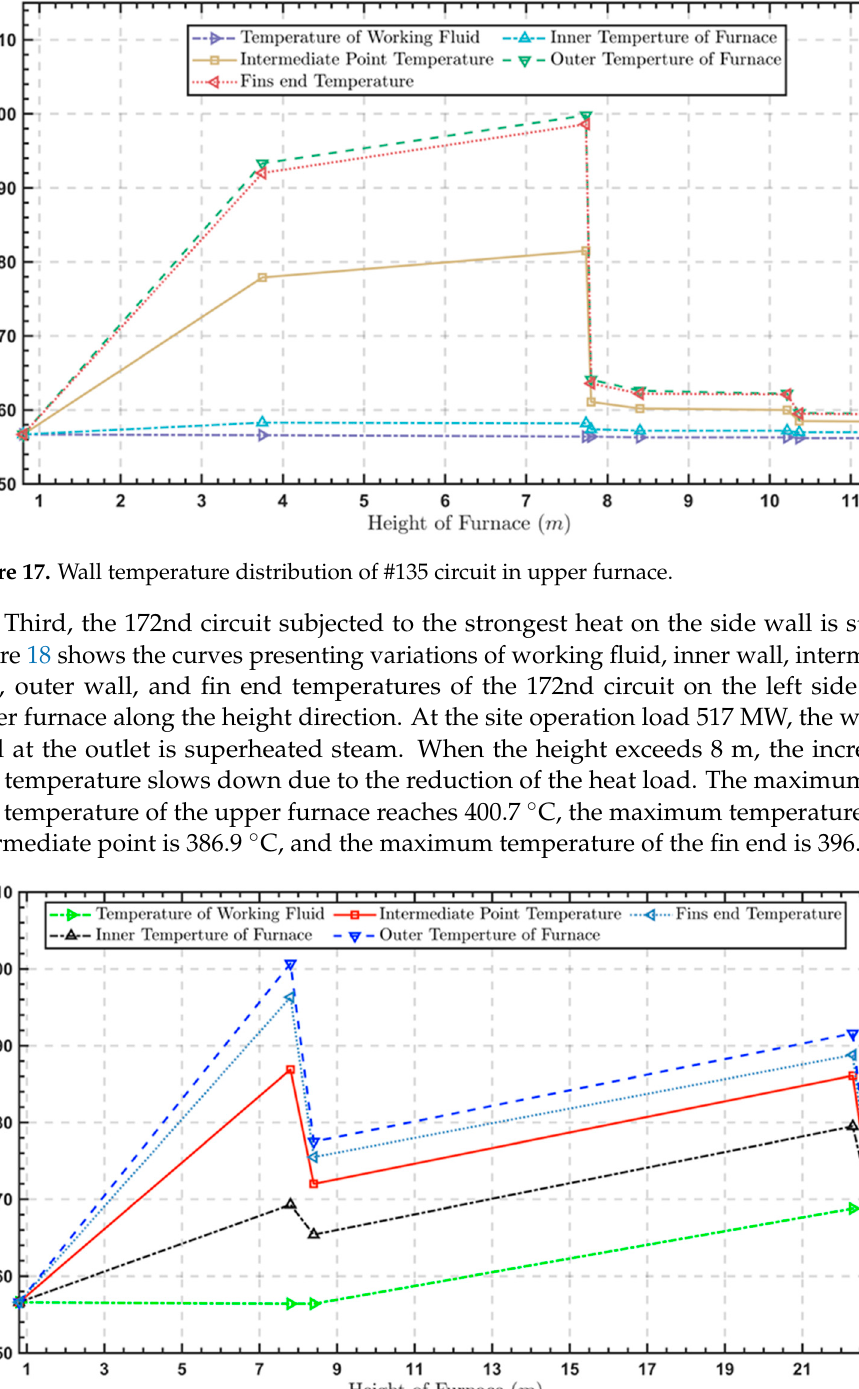
Figure 16. Wall temperature distribution of #95 loop in upper furnace.